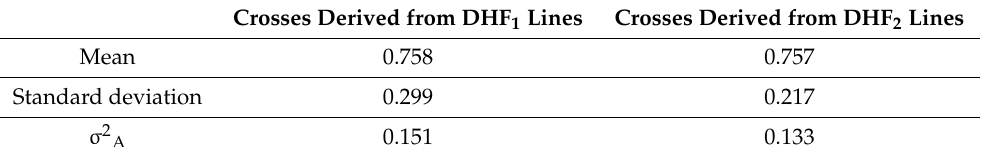
Table 8. Mean yield in testcross progenies of doubled-haploid lines produced from F 1 and F 2 generations of the cross VL1043 × CM 212.